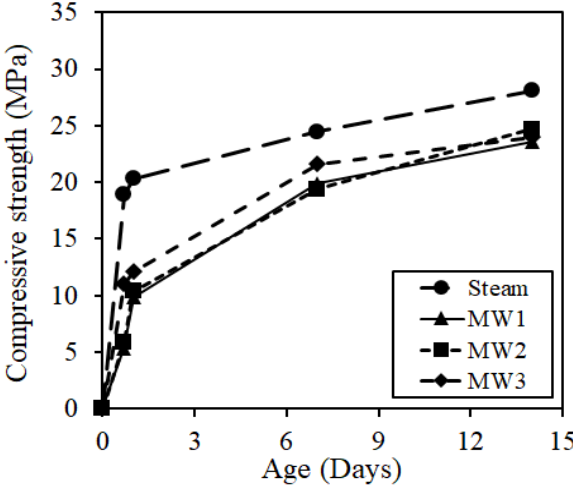
Figure 12. Compressive core strength.